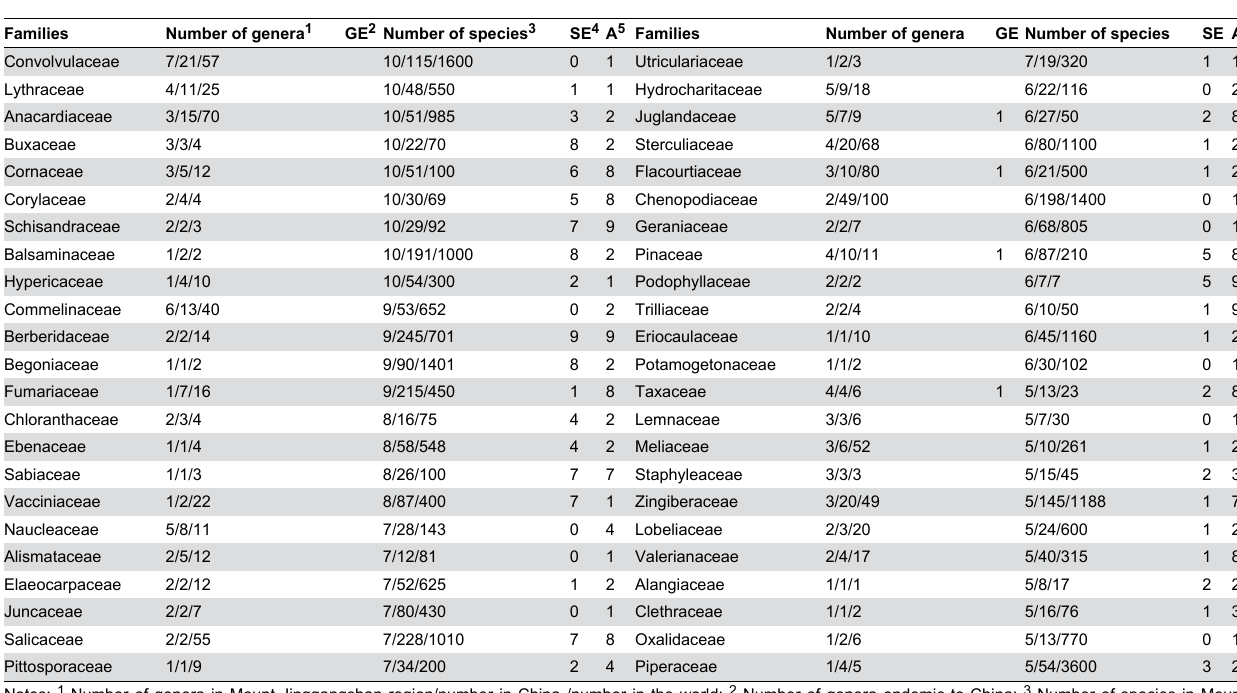
Table 4. Ranking of families (with 5-10 species) in Mount Jinggangshan region based on numbers of genera and species.